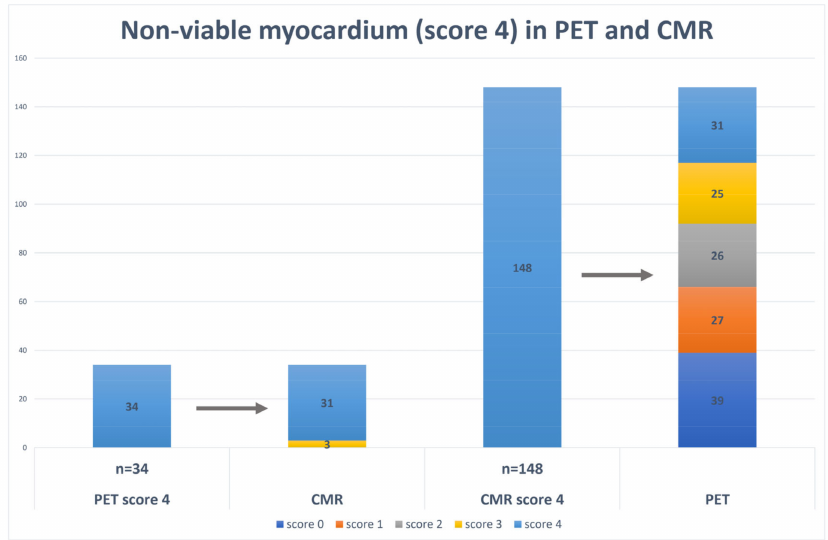
Figure 2. Non-viable myocardium (score 4) comparison within two imaging modalities (PET and CMR